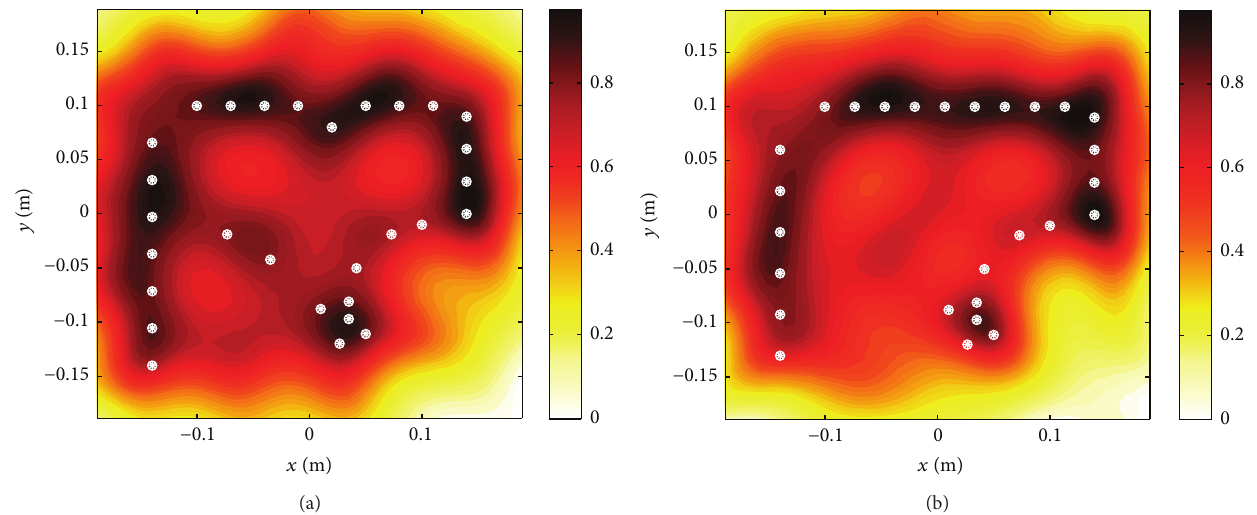
Figure 13: LSM indicator for flipped example 2 in a triangular cavity. (a) Measurement configuration A and (b) measurement configuration B.